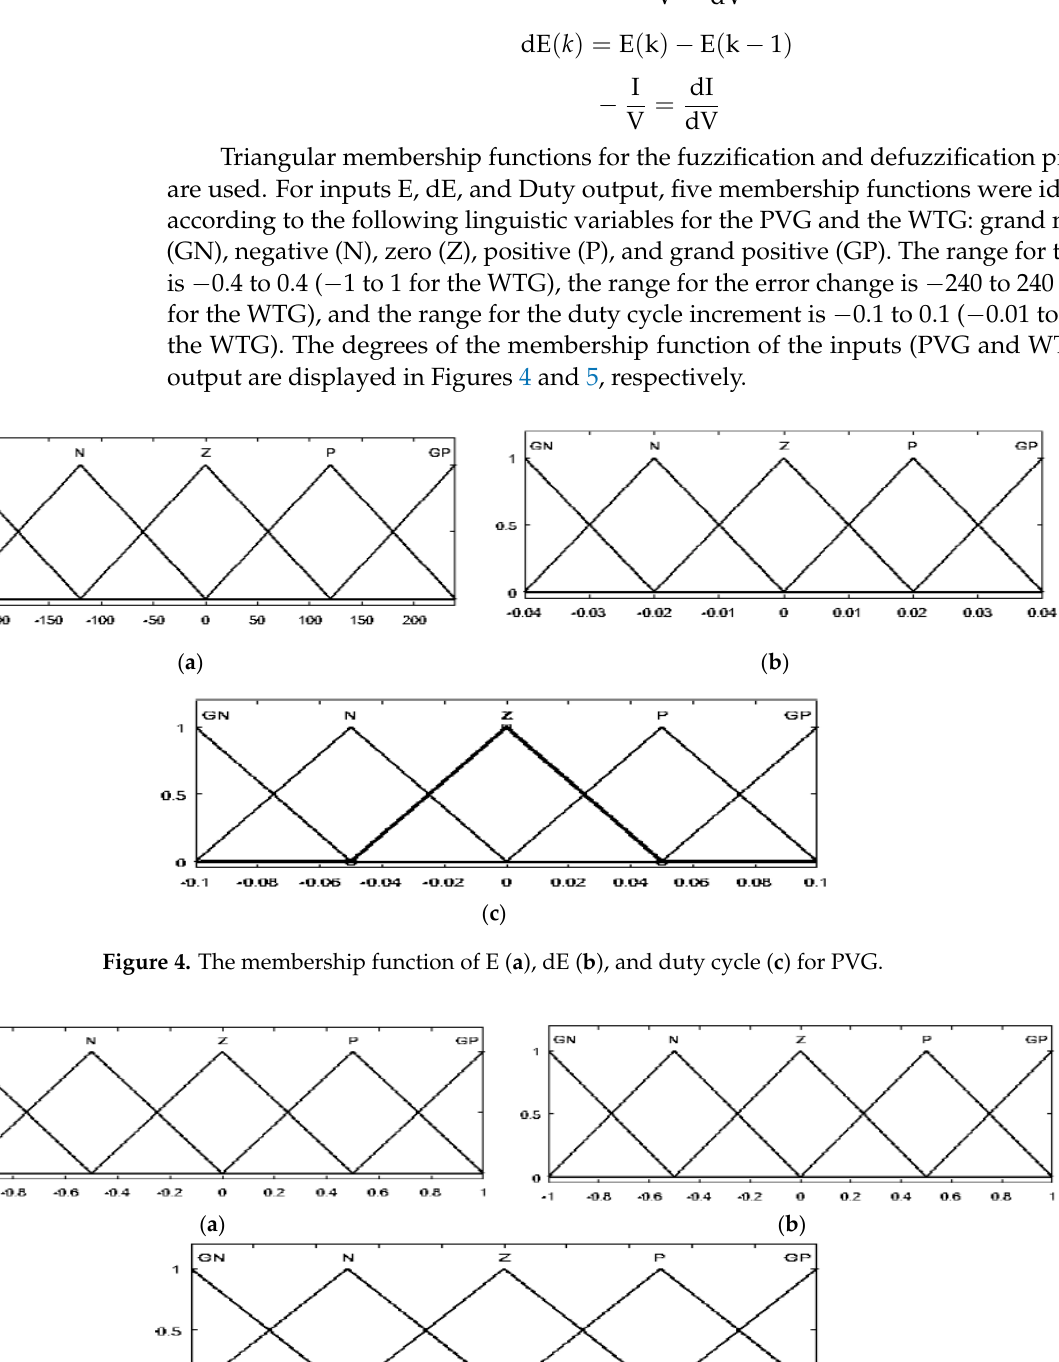
Figure 5. The membership function of E ( a ), dE ( b ), and duty cycle ( c ) for WTG.